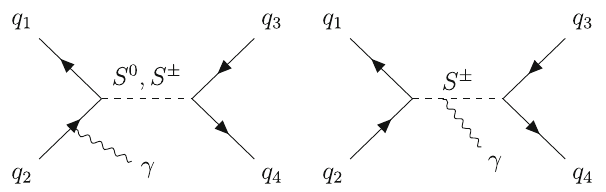
Fig. 1 Feynman diagrams for di-jet production via a scalar resonance in association with initial-state photon